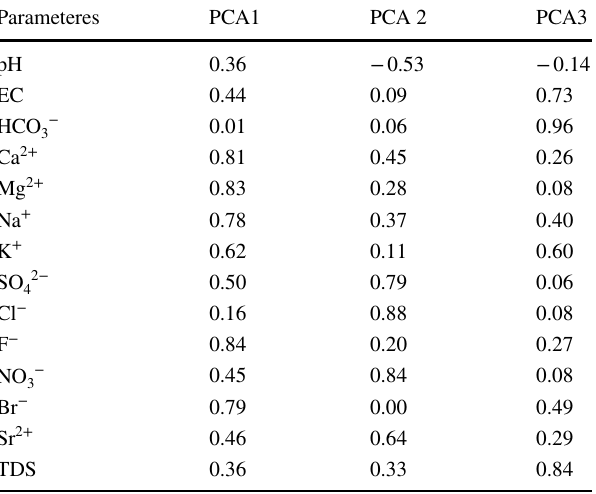
Table 4 Principal components of the hydrochemical parameters